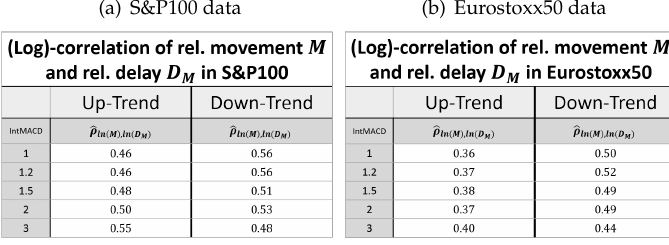
Table 10. Correlation between the logarithms of the relative (rel.) movement M and relative delay D M in up- and down-trends. ( a ) S&P100 data. ( b ) Eurostoxx50 data.